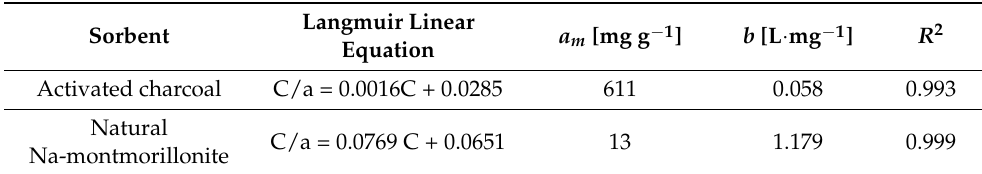
Figure 10. Diazepam adsorption isotherm for mineral clay; T = 37.0 ± 0.1 ◦ C; pH = 6.80 ± 0.05; S:L ratio = 1 g/L; ▪ experimental data; and — Langmuir-fit adsorption curves. In Table 8 the Langmuir equilibrium parameters for diazepam adsorption on acti- vated charcoal and natural Na-montmorillonite are presented. Table 8. Parameters a m and b for diazepam adsorption on activated charcoal and natural Na-montmorillonite.